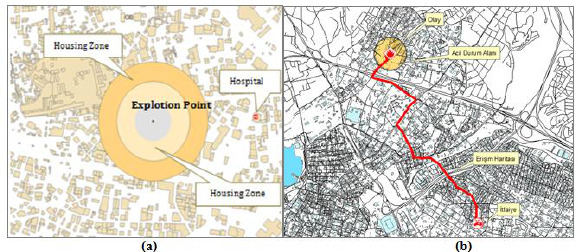
Table 2. Data requirement analyse for ‘Determining Affecting Area and Building’ activity.